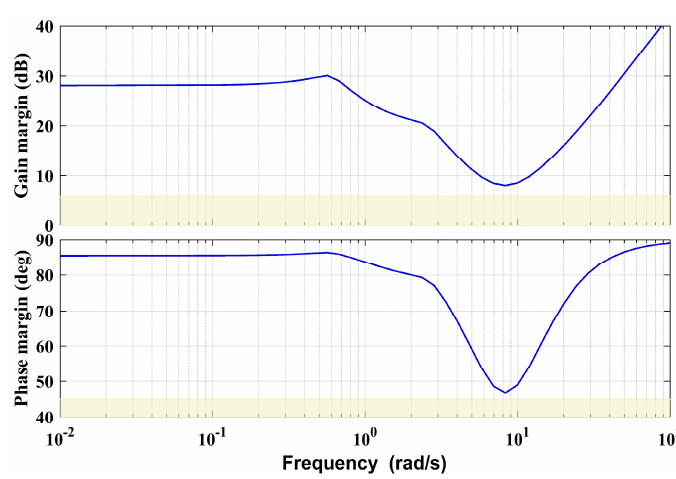
Figure 4. The configuration of the aerial platform controller.